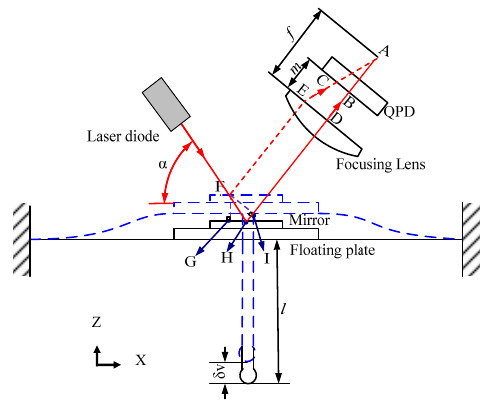
Figure 3. Detecting principle of the probe in Z ‐ motion.